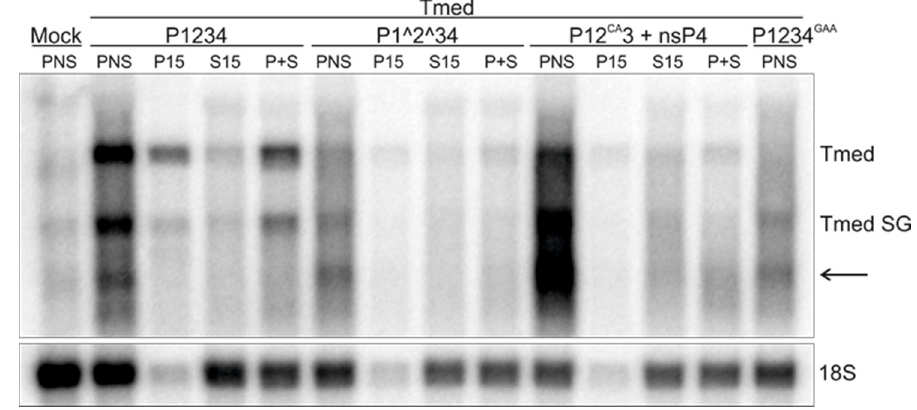
Figure 4. In vitro activity of replication complexes formed by expressing different SFV replicase constructs and a template in the trans-replication system. BSR cells were transfected and PNS, P15, and S15 were prepared as in Figure 3. Replication activity was determined by measuring the incorporation of 32 P-CTP into viral RNA after separation in denaturing agarose gels. The genomic and subgenomic RNA are indicated by Tmed and Tmed SG, respectively. P+S indicates a reaction containing equal volumes of P15 and S15 fractions, and each reaction contained an equivalent amount of PNS, P15, or S15. The arrow indicates an unspecific band. Ribosomal 18S RNA was detected by in-gel hybridization of the same gel. Data are representative of at least two independent